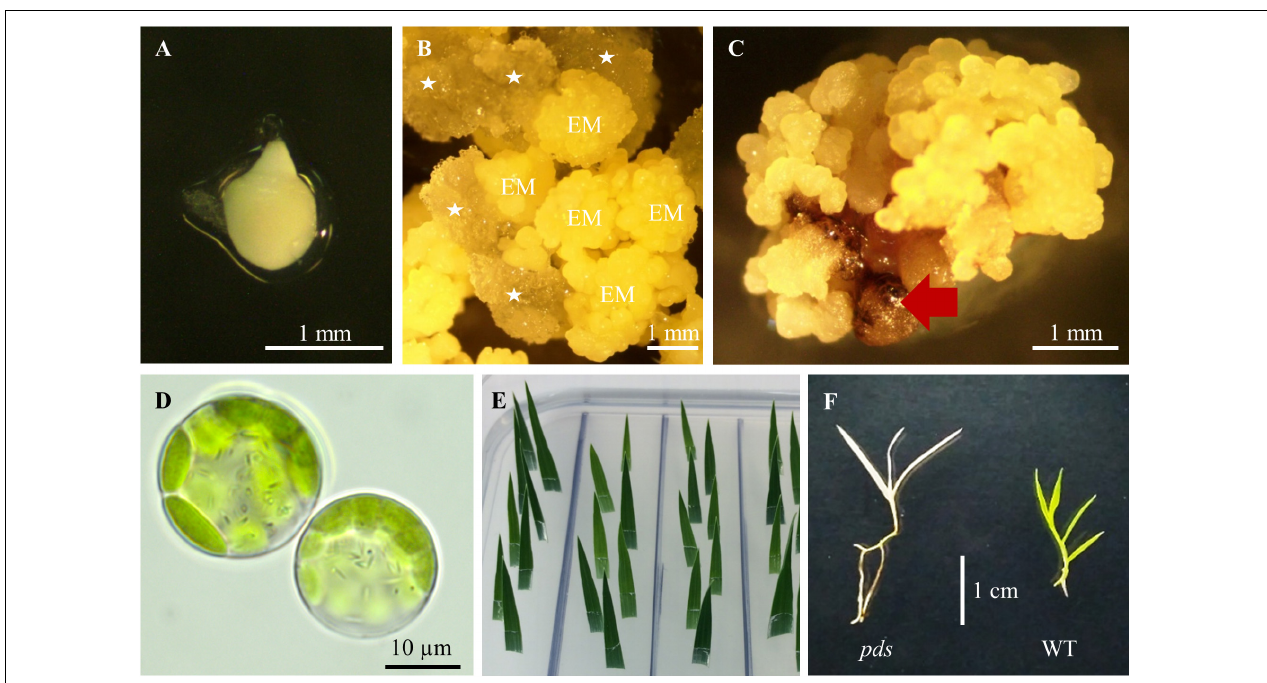
FIGURE 3 | Tissue culture in B. distachyon . (A) Immature embryo used for callus induction. (B) Induced callus: EM – embryogenic masses; parenchymatous cells are marked by white asterisks. (C) Embryogenic callus after transformation. Non-transformed calli are indicated by the red arrow. (D) Two day-old protoplasts of B. distachyon . (E) HygR test with B. distachyon leaves. (F) Albino phenotype of the B. distachyon . pds mutant in comparison to the green wild-type (WT)